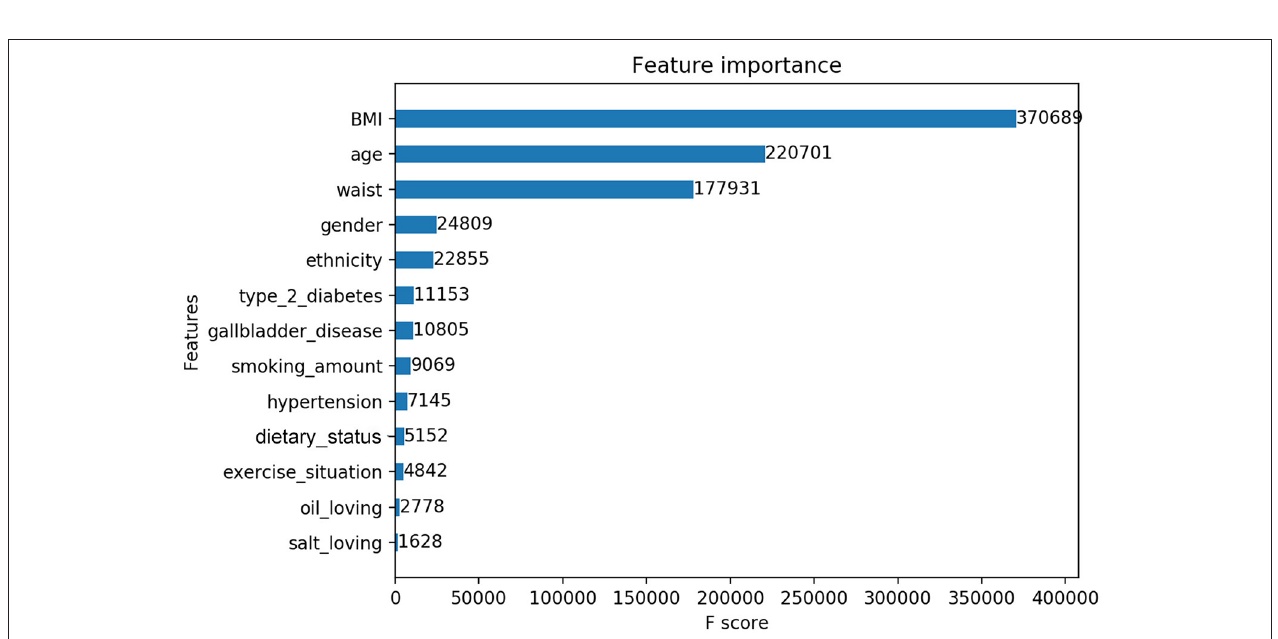
FIGURE 3 | ROC curve of all algorithms. LR, logistic regression; RF, random forest; NB, Naive Bayesian; XGB, XGBoost.